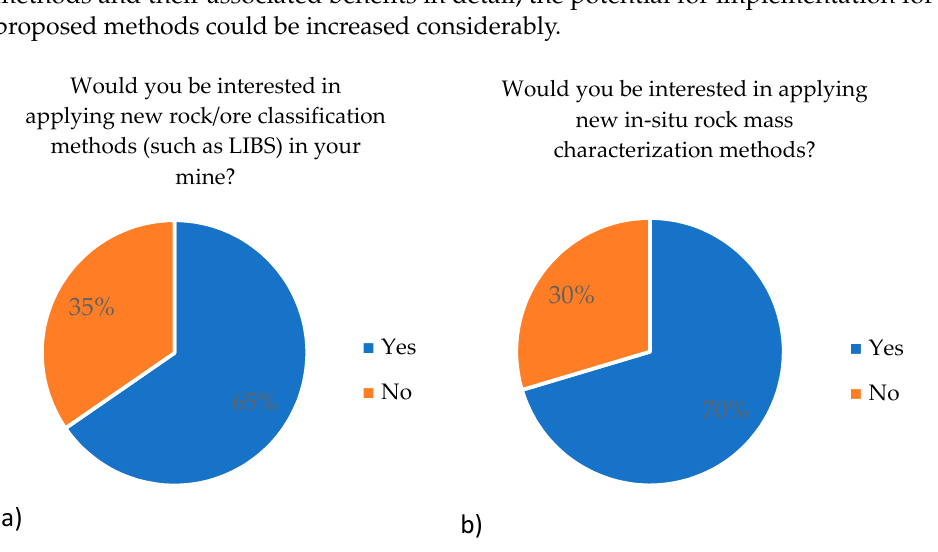
Figure 14. Interest in new rock and ore classification methods ( a ) and rock mass characterization methods ( b ).